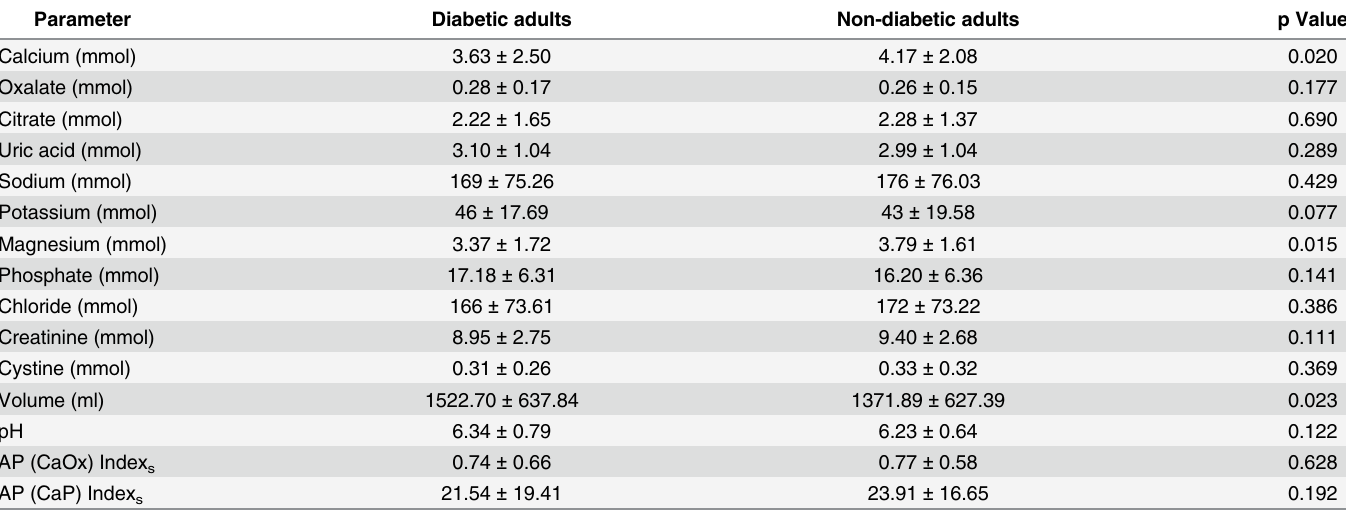
Table 2. Mean 24-h urinary excretion in diabetic and non-diabetic adults. Parameter